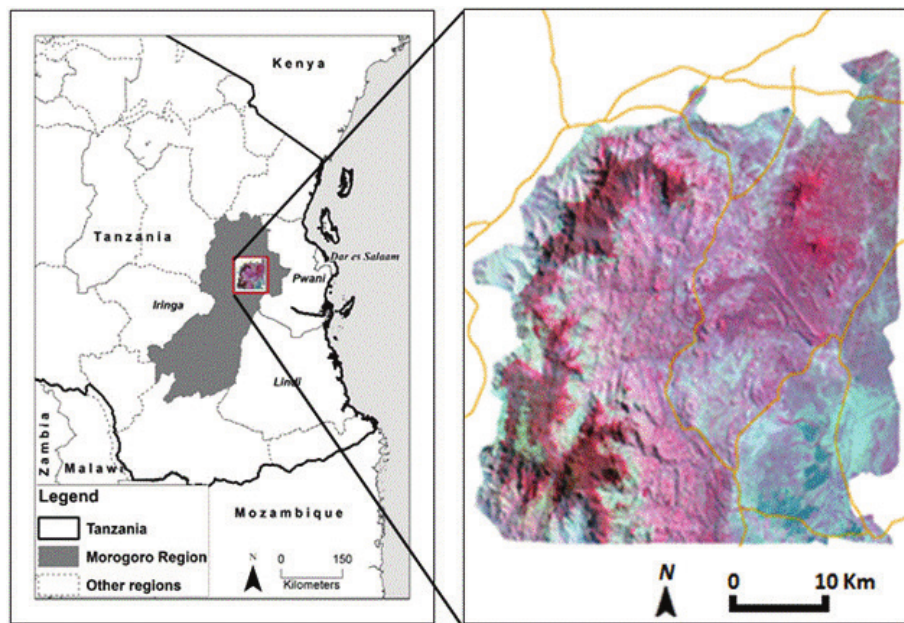
Figure 1. A 1975 Landsat composite overlaid on the study